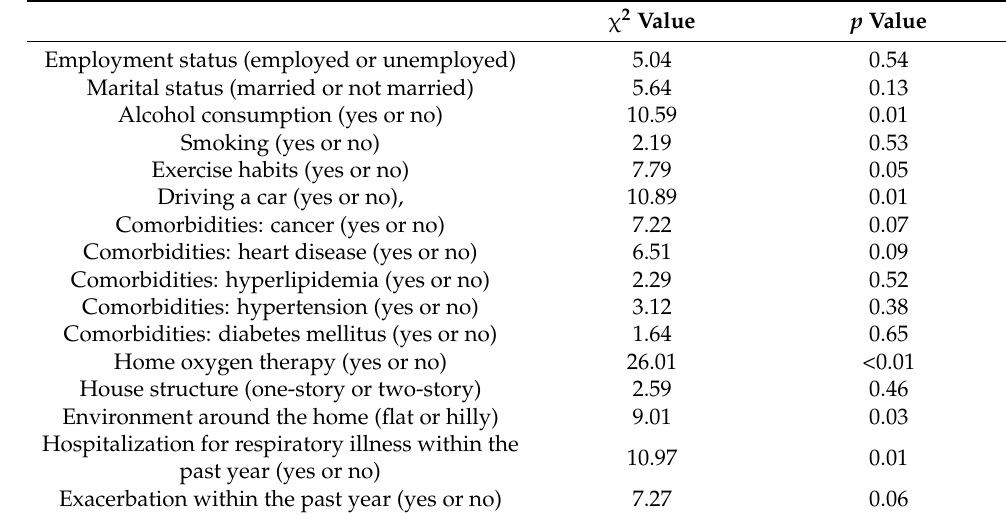
Table 2. Relationship with social background in the LoFlo + HiEx, HiFlo + HiEx, LoFlo + LoEx and HiFlo + LoEx groups.